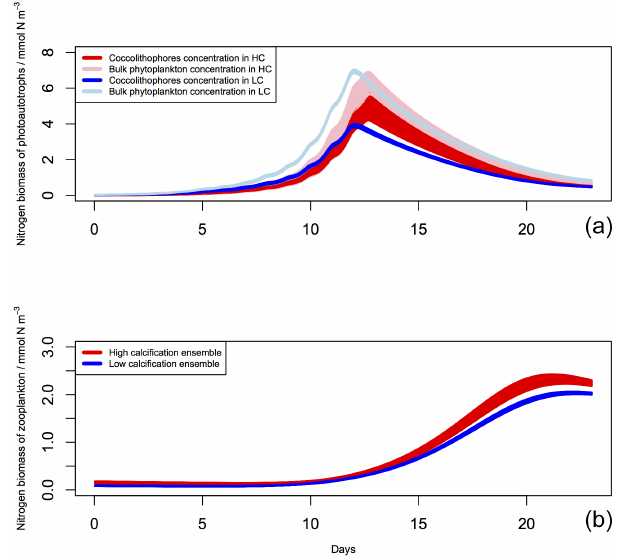
Figure 12. Simulated nitrogen biomass concentrations of photoau- totrophs and zooplankton in high and low calcification